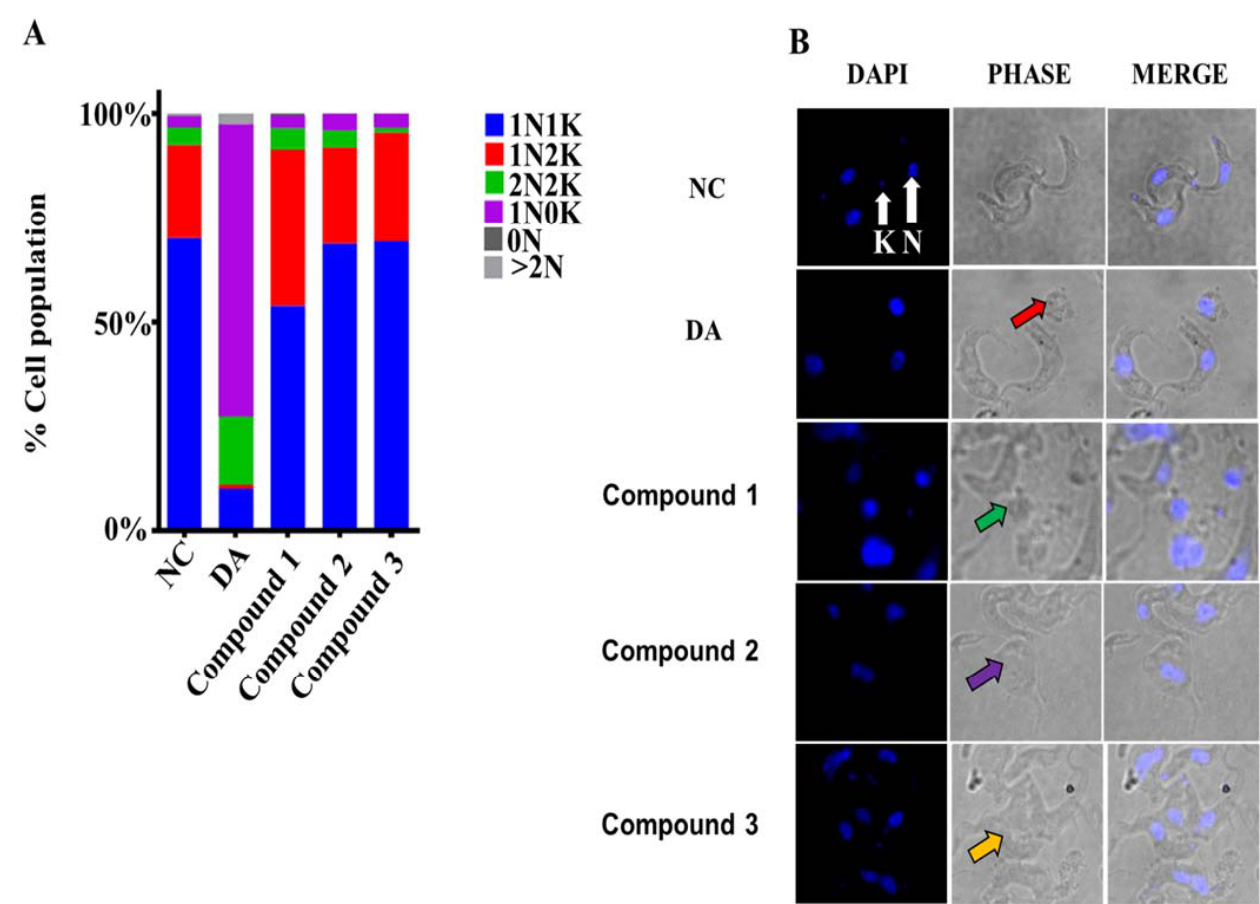
Figure 3. Effects of compounds on structure and distribution of T. brucei: T. brucei cells were treated at the EC 50 values of compounds. ( A ) For each compound, percentage cell population was calculated from an average count of 240 cells in 10 microscopic fields. ( B ) Red arrow = DA-treated cells; green arrow = compound 1 -treated subpopulation; purple arrow = compound 2 -treated subpopulation; orange arrow = compound 3 -treated subpopulation; K = kinetoplast; N = nucleus; PHASE = Phase contrast; DAPI = 4 ′ ,6-diamidino-2-phenylindole; DA = Diminazene aceturate; NC = Negative control.